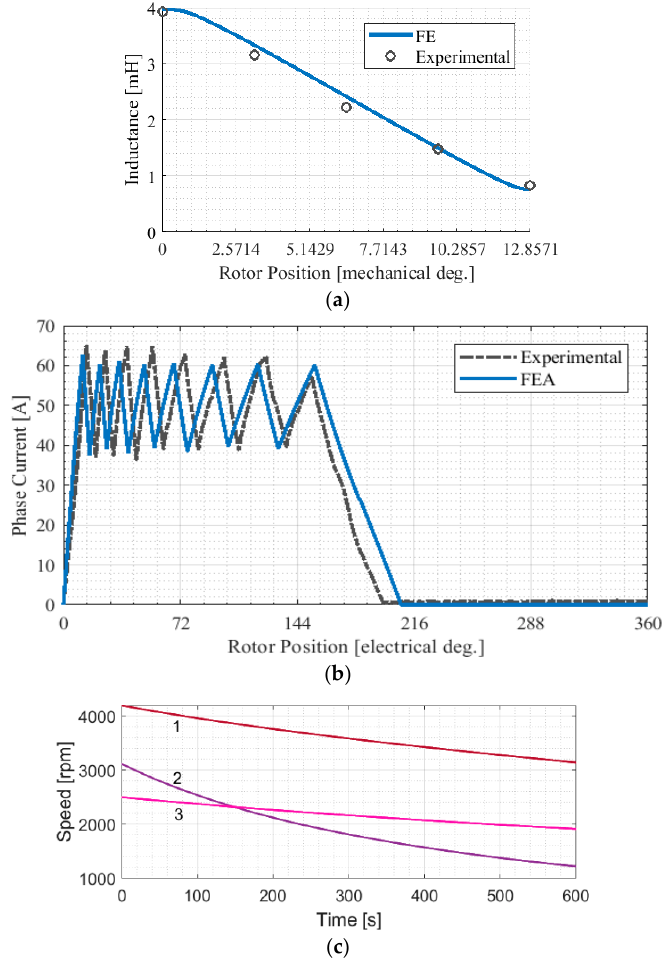
Figure 14. Preliminary experimental results: ( a ) inductance vs. rotor positions profile; ( b ) current waveform at 1120 rpm; ( c ) 10-min decelerations, speed vs. time plots.